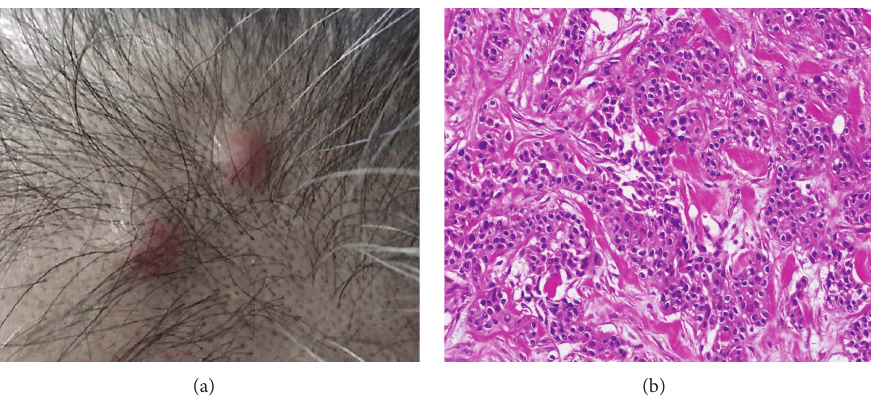
Figure 1: (a) Clinical image showing multiple 1cm sized erythematic nodules on the head. (b) The excisional biopsied skin sample from the head showing individually scattered and nested pleomorphic tumor cells in the dermis, which is consistent with metastatic urothelial carcinoma (H&E staining × 200).